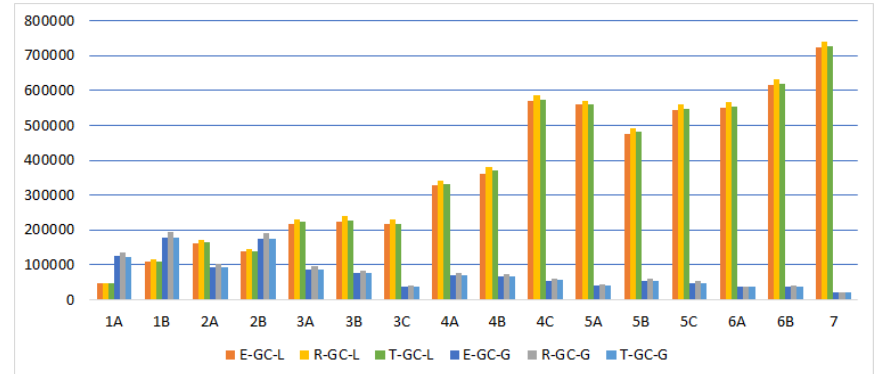
Fig. 4. Comparison of heat gains and losses from glazing conduction in 3 models